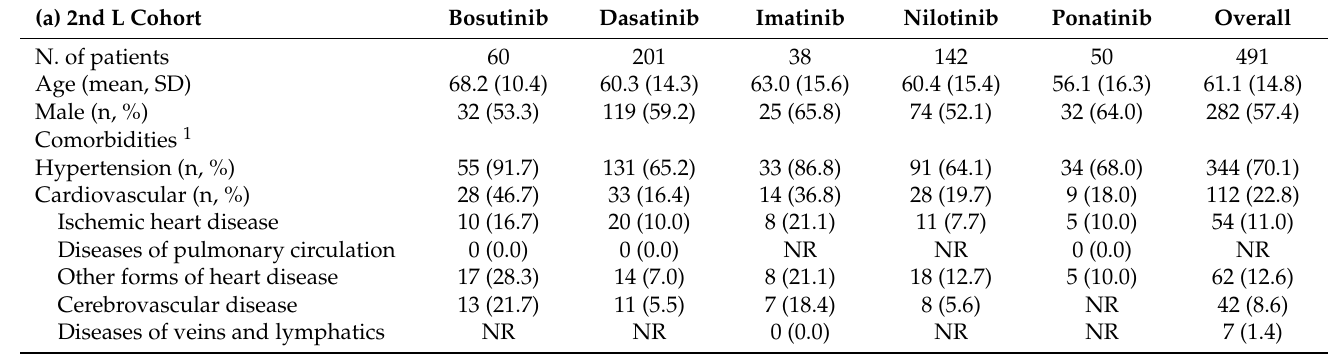
Table 1. Baseline characteristics of patients in 2nd L ( a ) and ≥ 3rd L ( b ) cohorts stratified by TKI